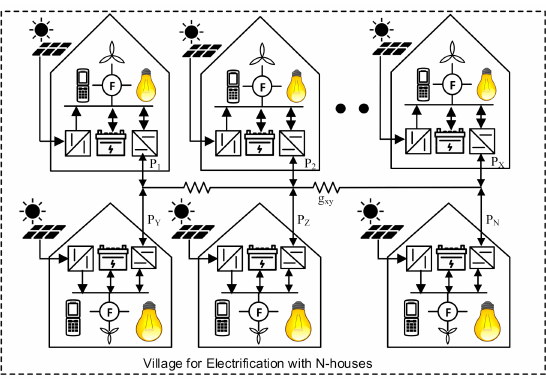
Figure 4. System diagram for distributed generation and distributed storage architecture